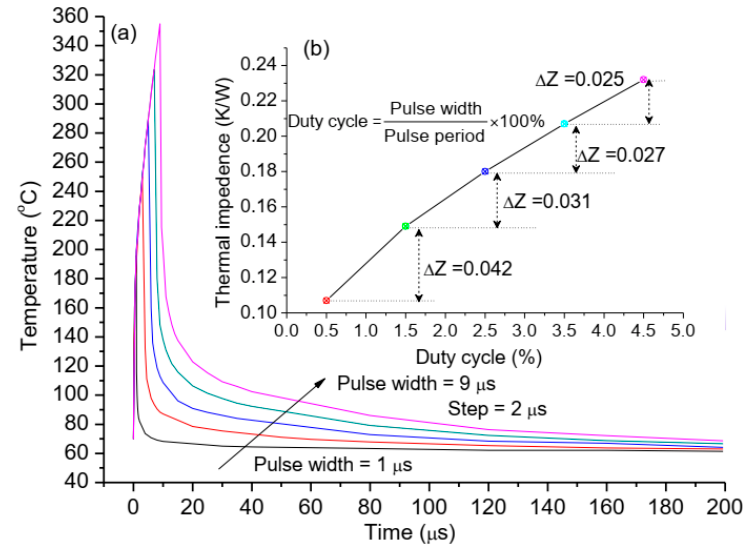
Figure 4. ( a ) Dependence of transient channel temperature on pulse width during one pulse period; ( b ) the impact of duty cycle on thermal impedance of device; the pulse width is 1 μ s, 3 μ s, 5 μ s, 7 μ s, and 9 μ s, respectively, according to the duty cycle of 0.5%, 1.5%, 2.5%, 3.5%, and 4.5%.